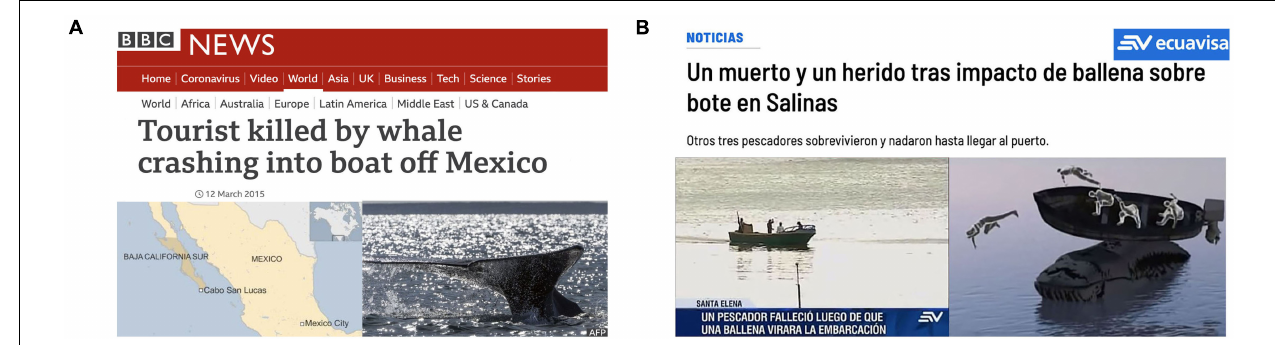
FIGURE 5 | (A) An online article from the BBC reporting on a vessel strike between a humpback whale and a tourism boat in Baja California, Mexico (March 12, 2015), which resulted in the death of one of the passengers. (B) An online article from Ecuadorian TV channel, Ecuavisa, (June 23, 2017) describing a vessel strike of a large whale near to Salinas, Santa Elena, Ecuador. A boat carrying five fishermen capsized on impact with the whale. Three men survived, one man was found dead, and one man was still missing after 24 h (at the time this article was published) and was never